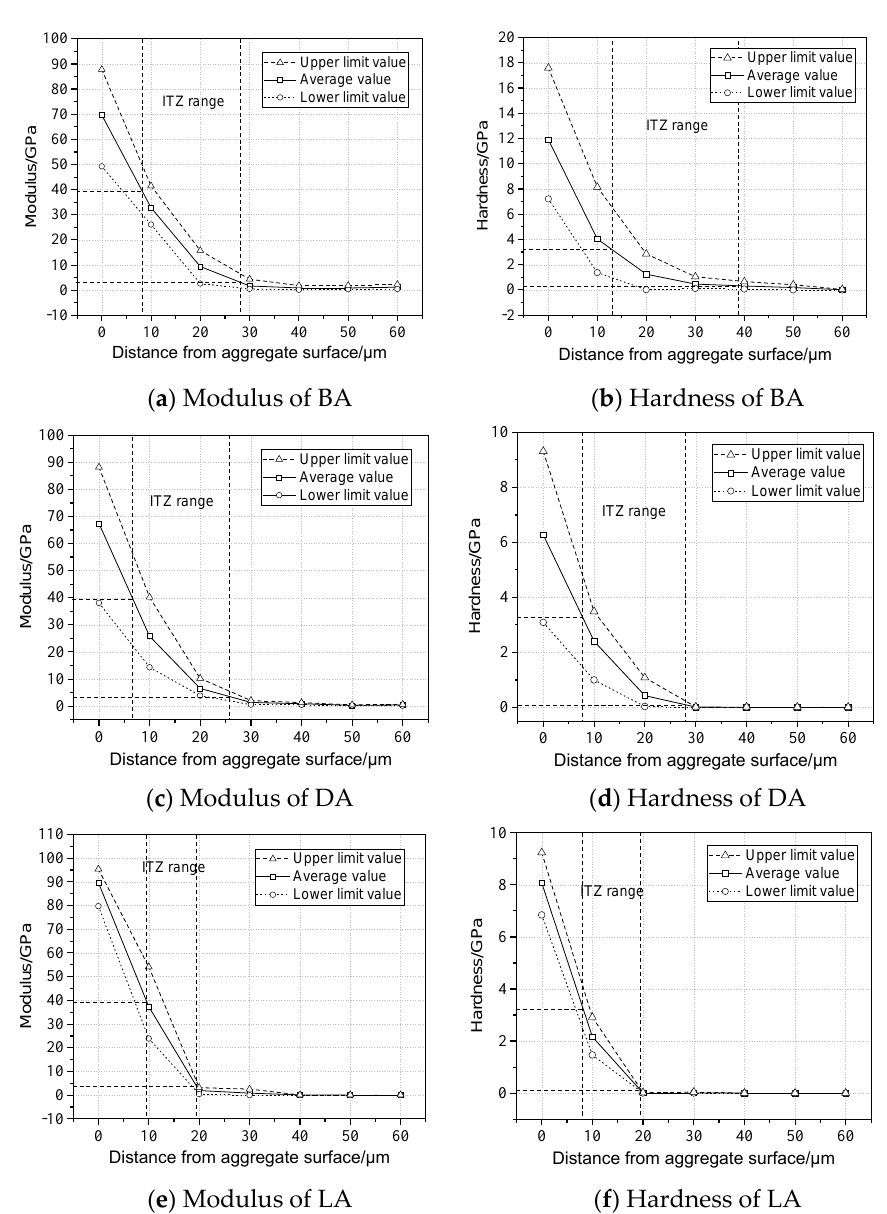
Figure 8 Modulus and hardness versus distance. ( a ) and ( b ) BA, ( c ) and ( d ) DA, and ( e ) and ( f ) LA.